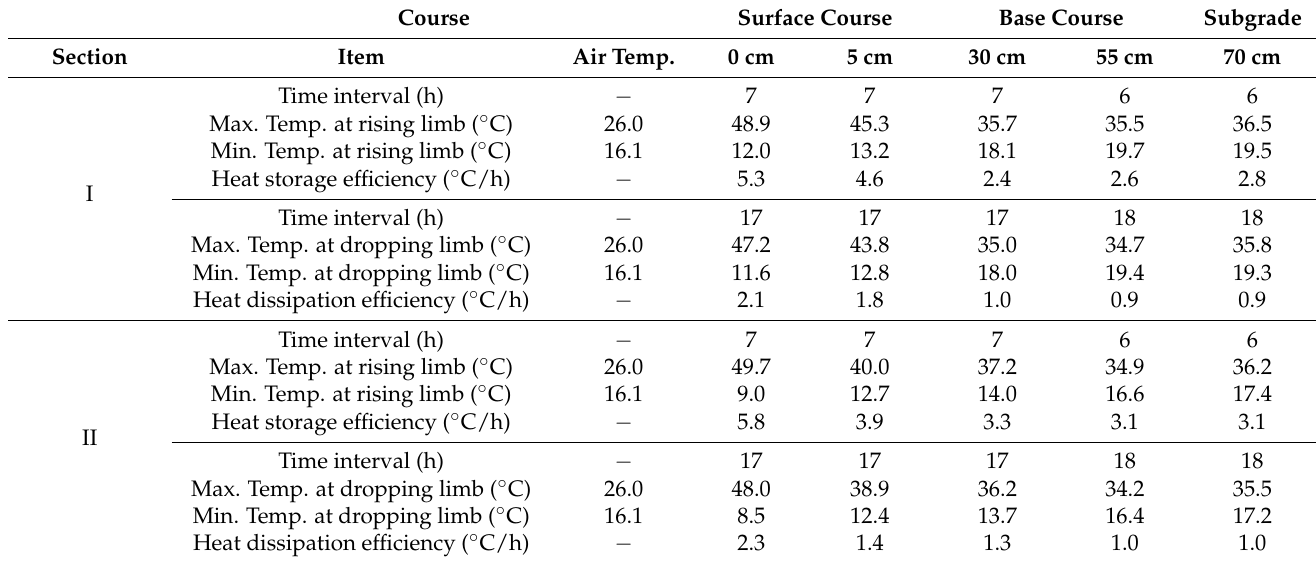
Table 4. Heat storage and dissipation efficiencies in 22nd–28th